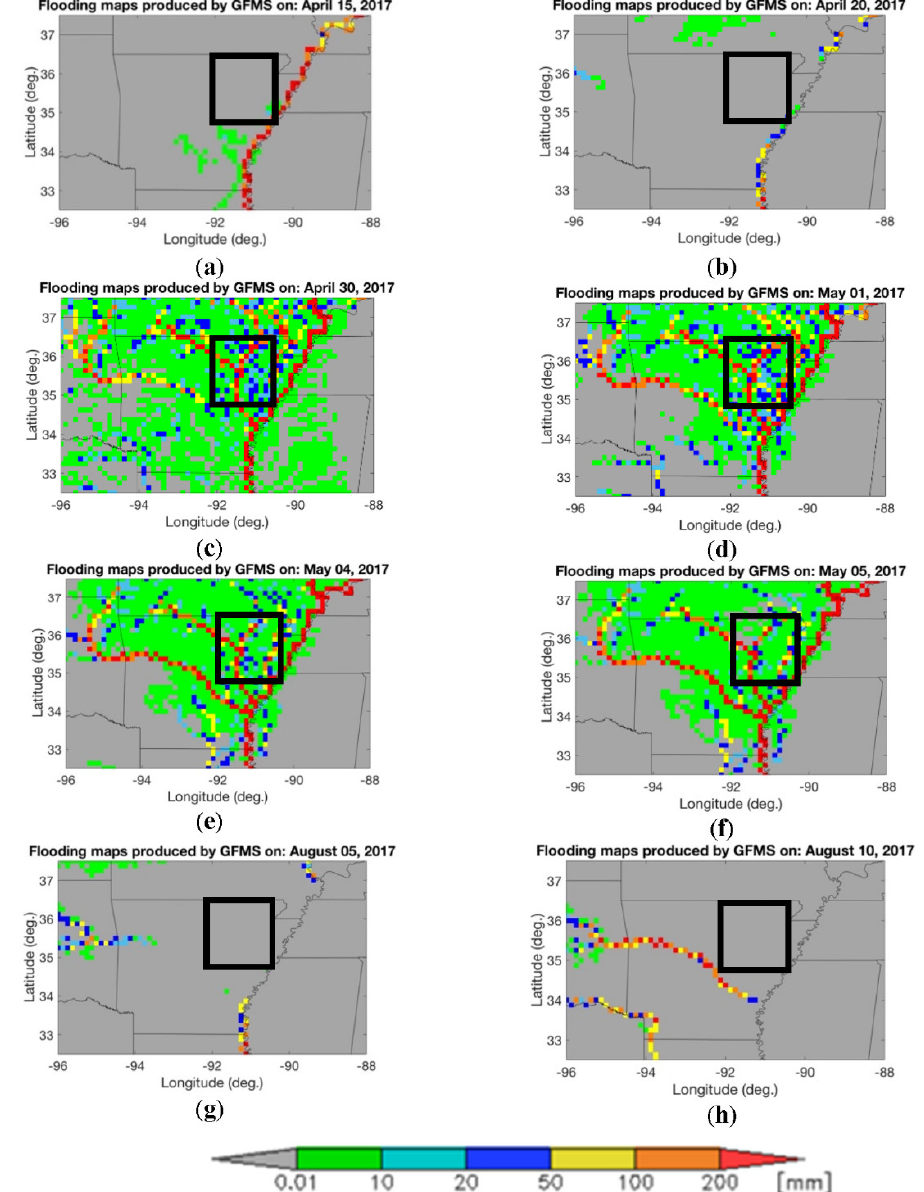
Figure 15. GFMS flood maps for the area under study on ( a ) 15 April 2017, ( b ) 20 April 2017 before Midwest spring floods occurred, then ( c ) 30 April 2017, ( d ) 1 May 2017, ( e ) 4 May 2017 and ( f ) 5 May 2017 during the floods, and ( g ) 5 August 2017 and ( h ) 10 August 2017 months after the floods occurred. The area under study is marked with a black box. The units are in depth above threshold in mm.